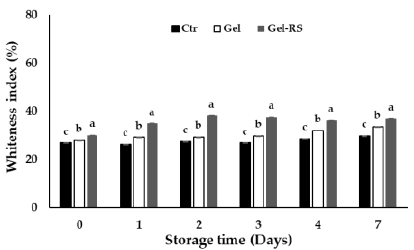
Figure 3. Whiteness Index (WI) of coated fresh cut zucchini samples during a 7-day storage period at 5 ◦ C. Black columns indicate Ctr treatment, white columns indicate Gel treatment and grey columns indicate Gel-RS treatment. Different letters indicate statistical differences. Different letters within the columns indicate significant differences ( p < 0.05) among the different treatments on every sampling date. Sample analysis was in triplicate.